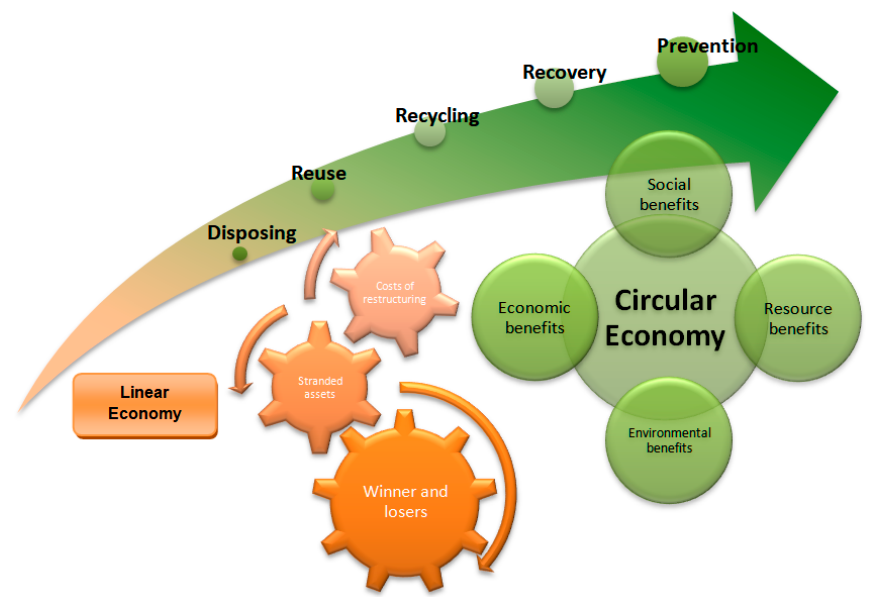
Figure 1. Transition from linear to circular economy model.